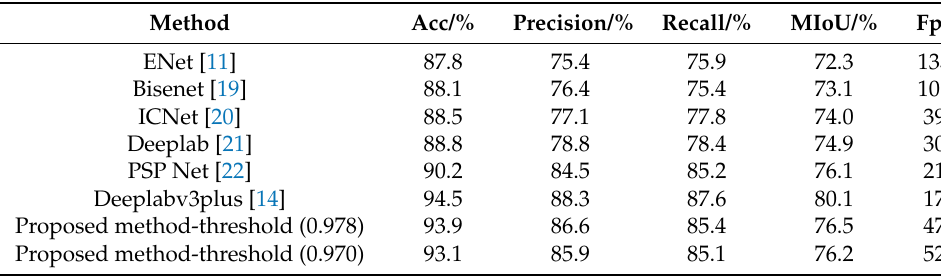
Table 2. Result of self-collected data set.